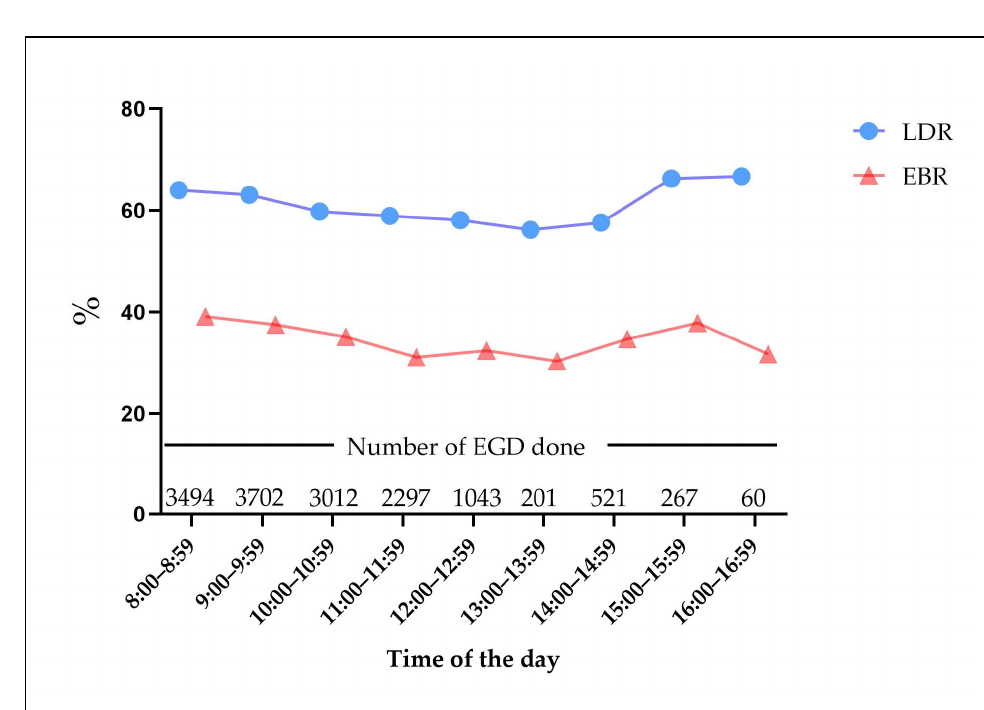
Figure 1. LDR and EBR as time progressed. The number of EGD corresponding to each hour denotes the total number of EGD conducted during that hour. EGD, Esophagogastroduodenoscopy; LDR, lesion detection rate; EBR, endoscopy biopsy rate.